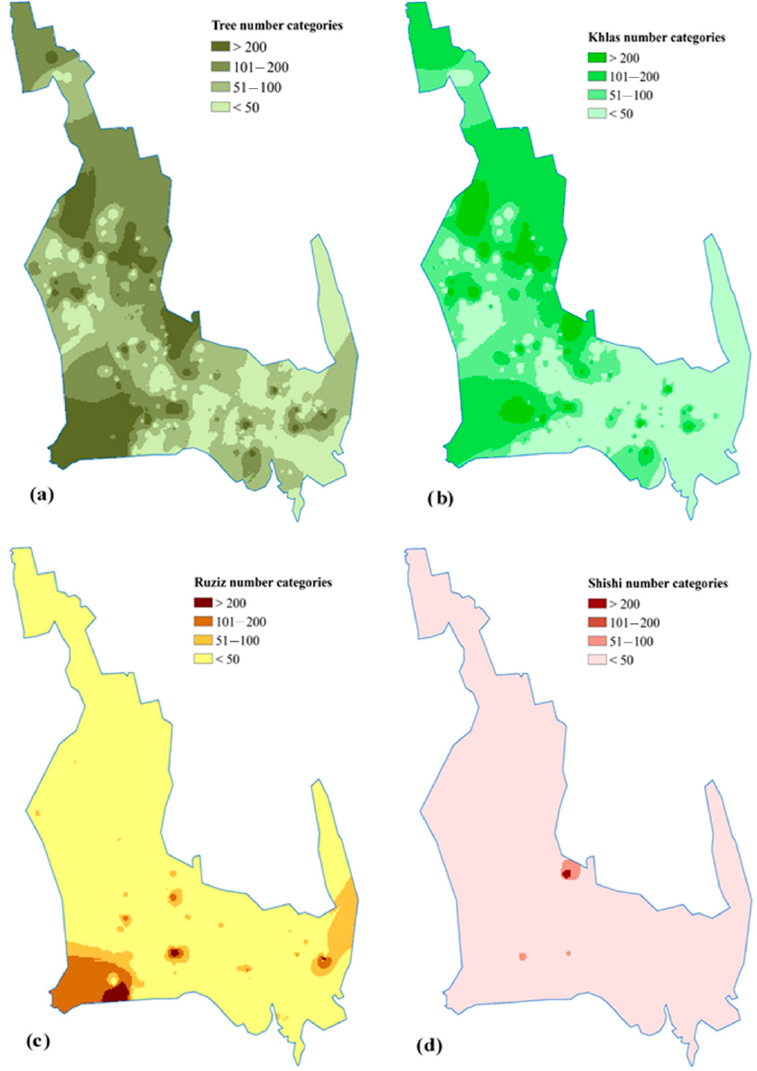
Figure 3. The plotted number of palm trees/farm, as in ( a ) the oasis total palm and in cultivars of ( b ) Khlas, ( c ) Ruziz, and ( d ) Shishi.